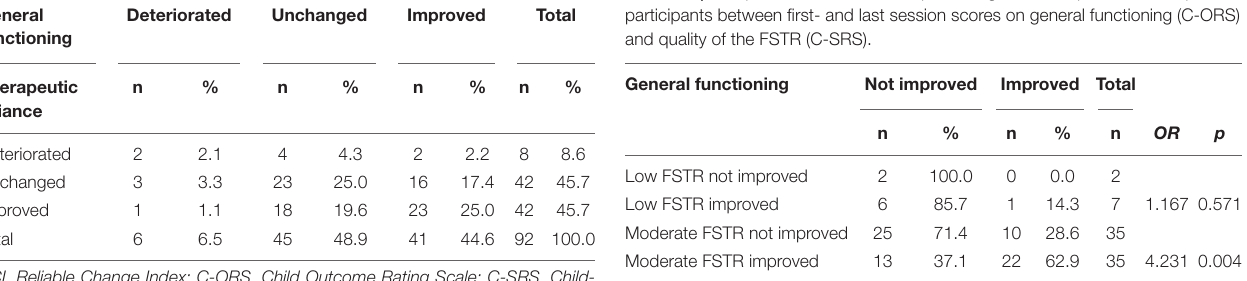
FSTR, First-session therapeutic